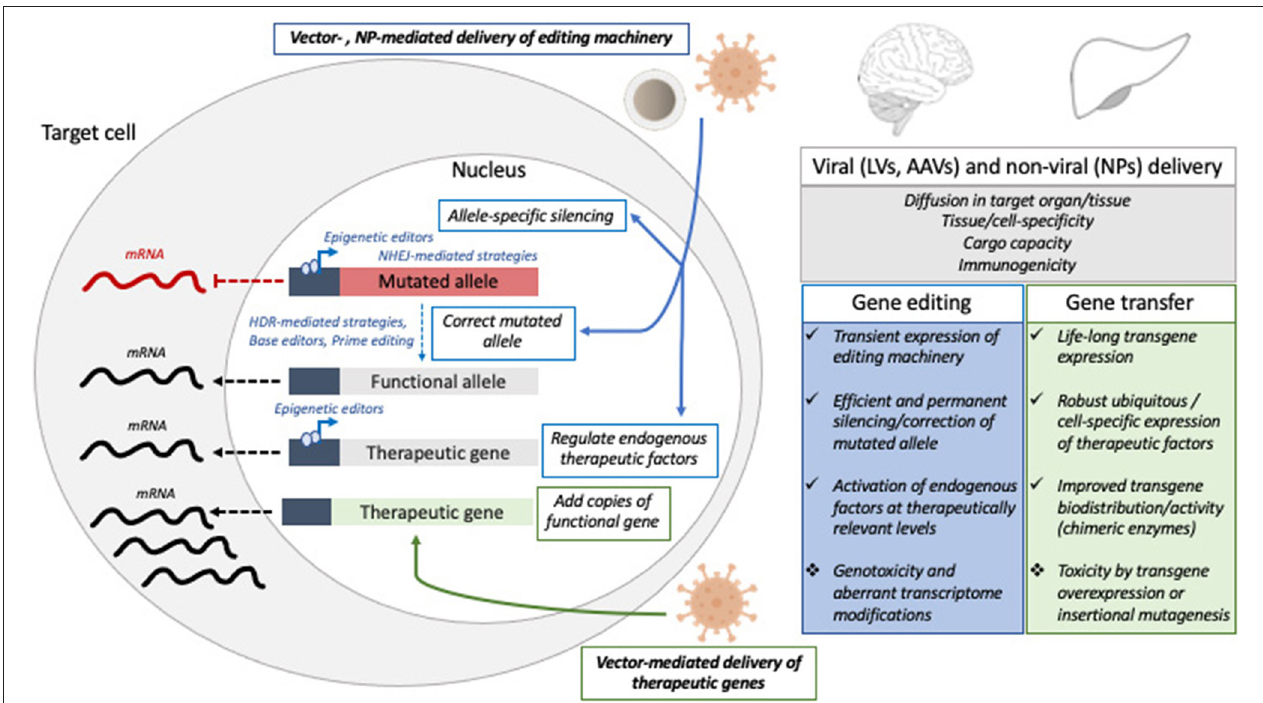
FIGURE 1 | Schematic representation of gene editing and gene transfer approaches tested in pre-clinical and clinical settings to treat liver or CNS disorders, with a list of the major hurdles and challenges that might be addressed to improve the efficacy and safety of in vivo GTMP. NP, nanoparticles; LV, lentiviral vectors; AAV, adeno-associated viral vectors; NHEJ, non-homologous end joining; HDR, homology-directed repair.